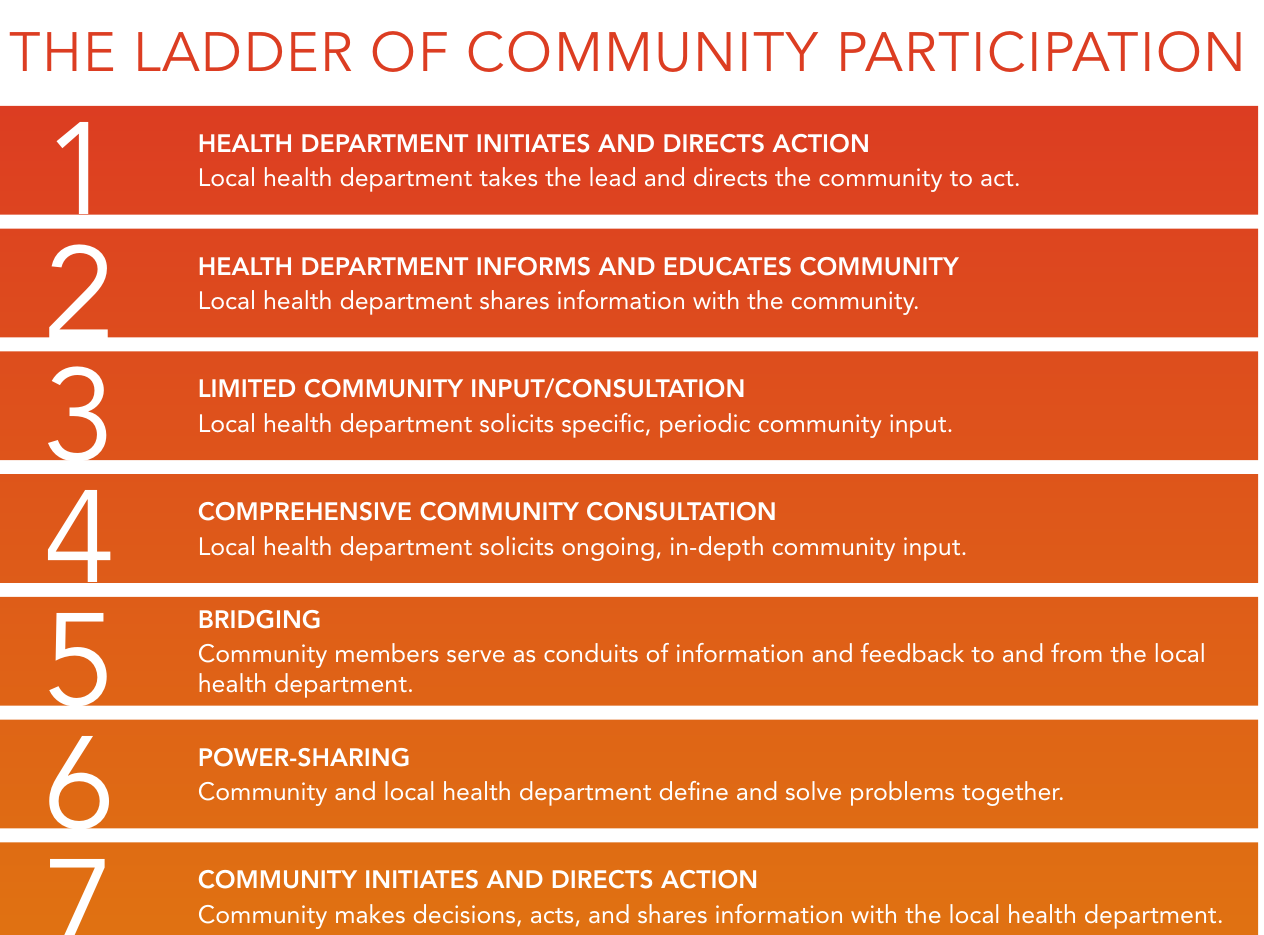
FIGURE 5. THE LADDER OF COMMUNITY PARTICIPATION Morgan, M.A., & Lifshay, J. (2006, March). Community engagement in public health. Martinez,